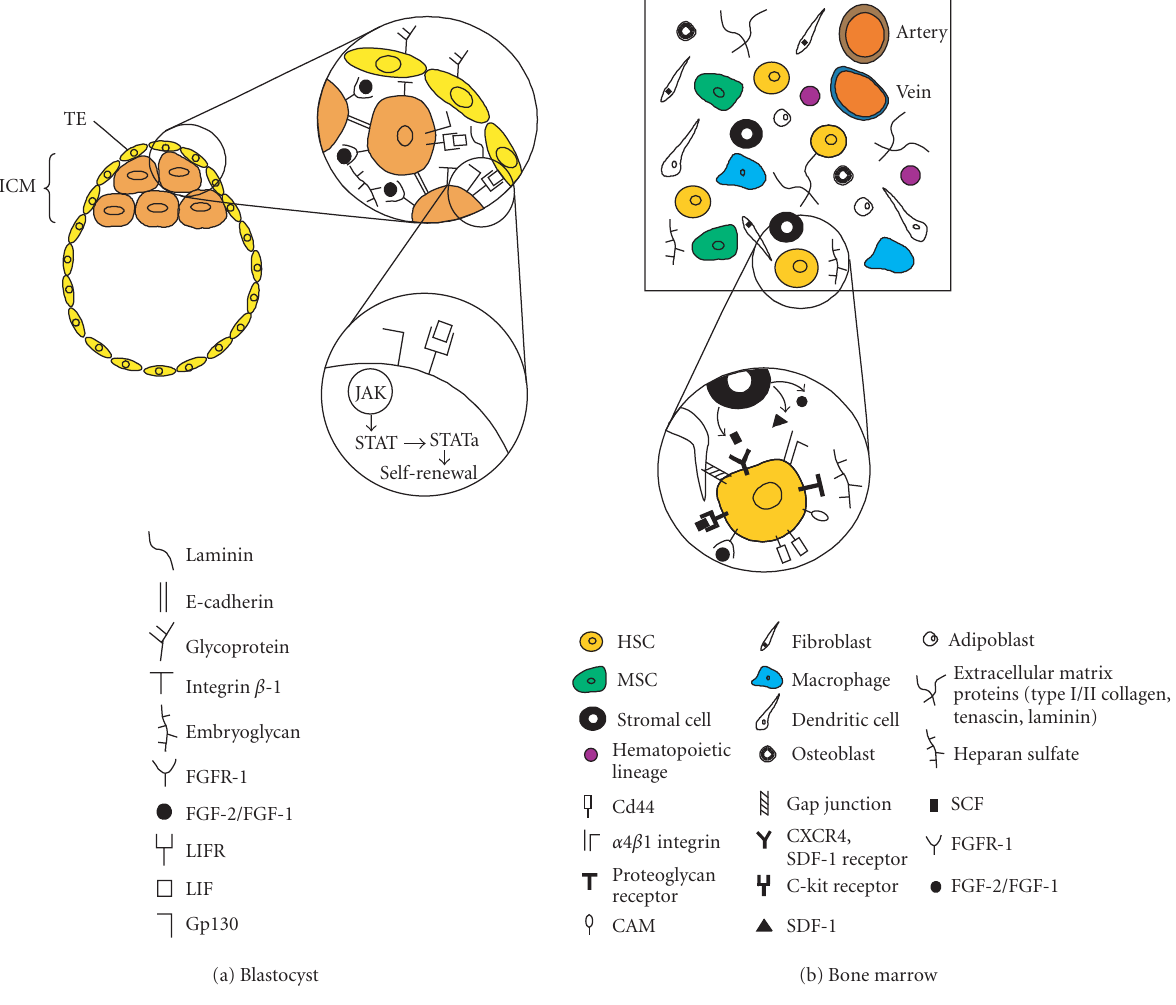
Figure 1. Schematic representation of the main components present in the blastocyst and bone marrow microenvironment. (a) Preimplanted embryo (blastocyst) composed by the inner cell mass (ICM) and the trophectoderm cell layer (TE). Abbreviations: FGF2/FGF, fibroblast growth factor 2 and 1; FGFR-1, fibroblast growth factor receptor-1; LIF, leukemia inhibitory factor; LIFR, leukemia inhibitory factor receptor; JAK, JAK kinase; STAT, transcription factor STAT; STATa, transcription factor STAT